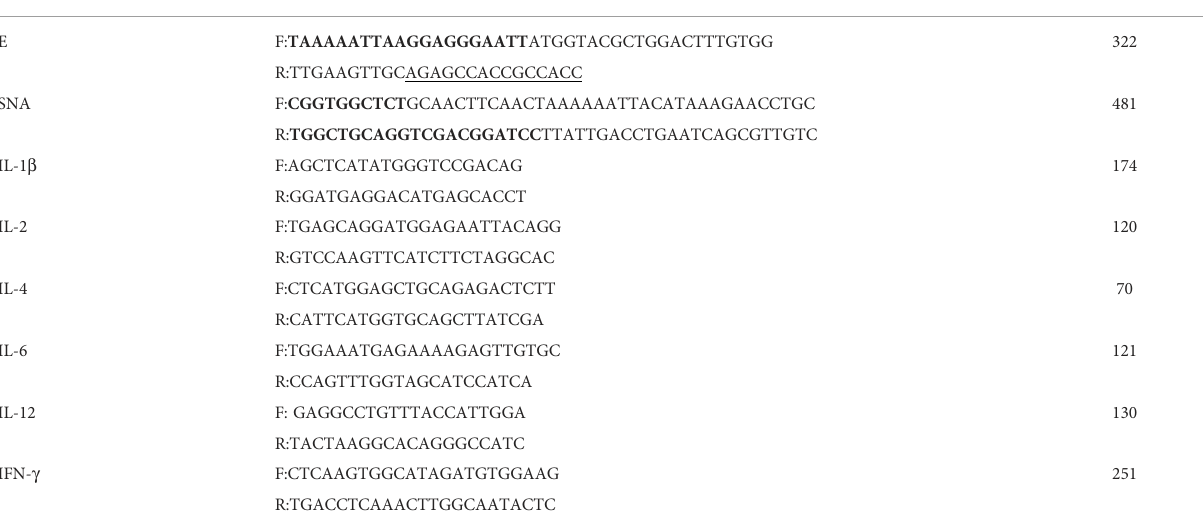
TABLE 1 Primer sequences of gene E and SNA